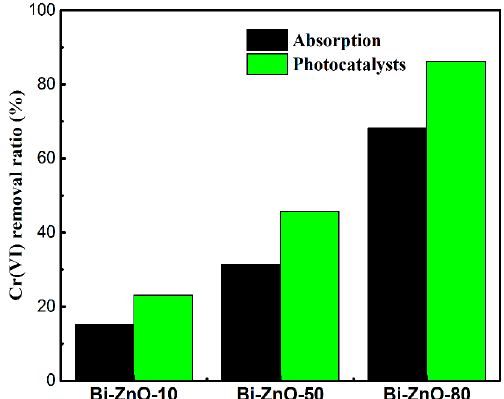
Figure 8. Removal ratio by physical adsorption and photocatalysis of Cr(VI) over Bi-ZnO-10, Bi-ZnO-50, and Bi-ZnO-80.